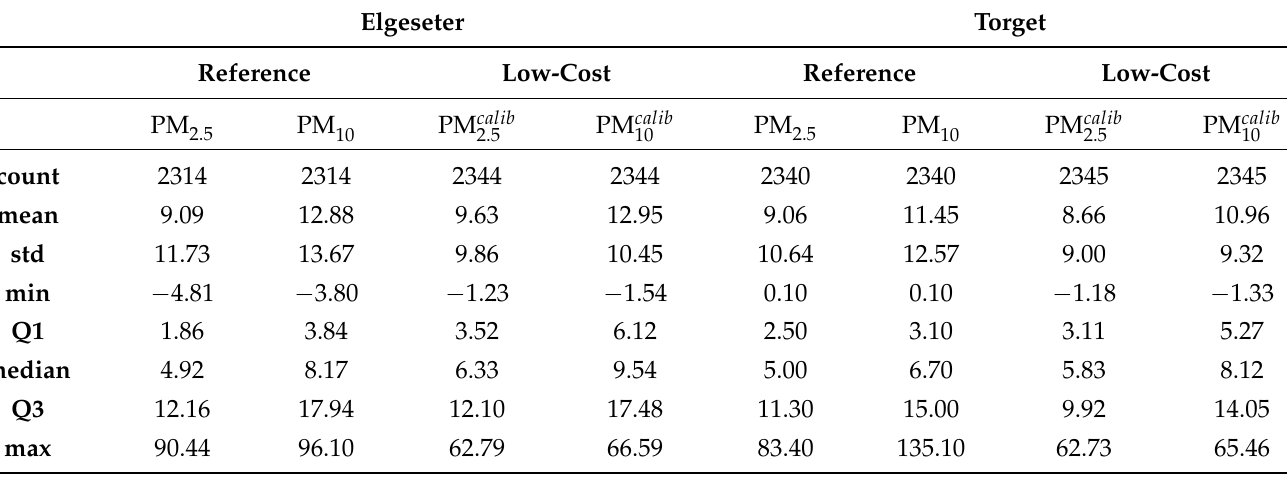
Table 4. Data collected between 15 November 2020 and 23 February 2021 for reference and calibrated low-cost sensors at locations where both are co-located (in µ g/m 3 ). Both sensors were calibrated using the model trained with Elgeseter data. Data were not pre-processed and we used reference data “as is” from the public API; therefore we maintained negative values that might be explained by the calibration procedures for industrial reference